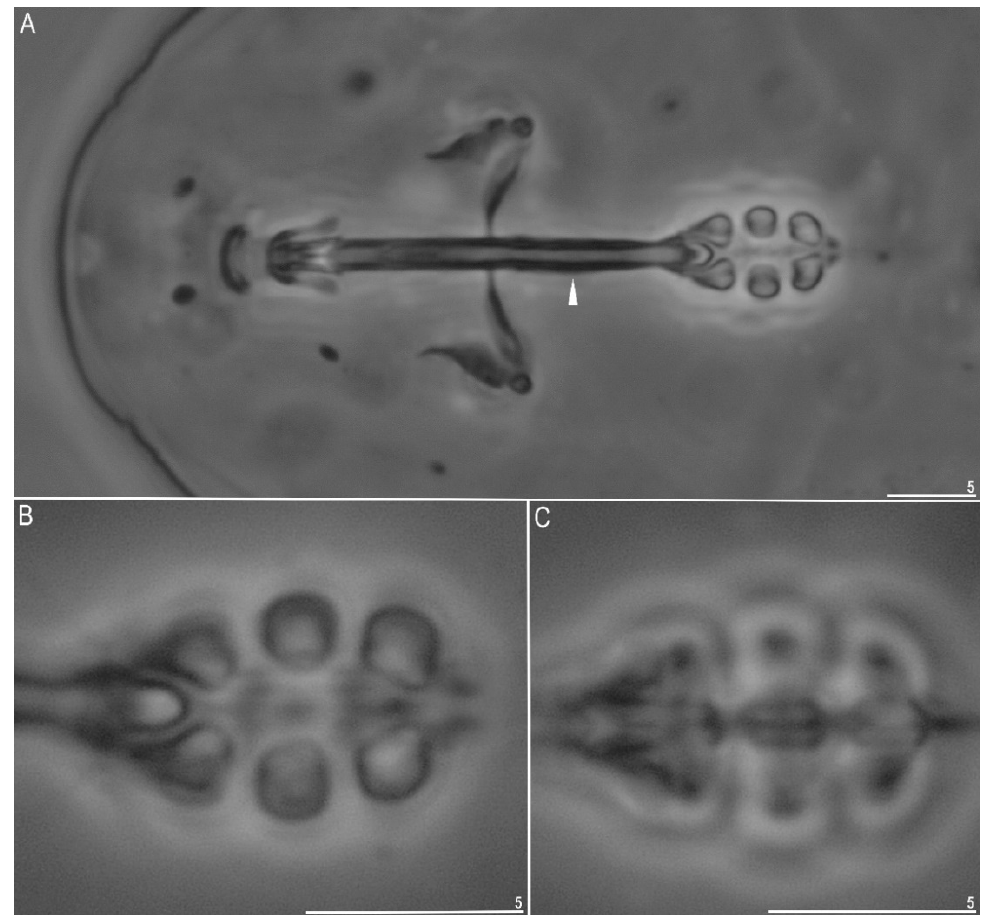
Figure 2. Minibiotus intermedius : ( A ) bucco ‐ pharyngeal apparatus, general view (neoparatype) (filled arrowhead indicates a thickening below stylet insertion point; ( B ) lateral rows of placoids (neoparatype); ( C ) central row of placoids (neoparatype). All in PCM. Scale bars in μ m.